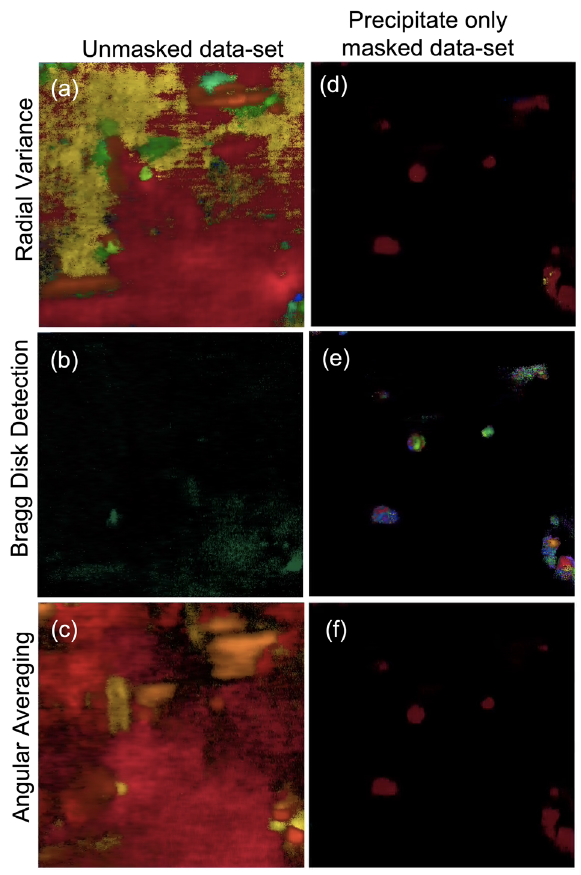
Fig. 13 Domain mapping using other techniques. The left column is the unmasked full thin foil Al alloy dataset clustered using a radial variance, b Bragg disk detection and c angular averaging. The right column is the precipitate-only masked thin foil Al alloy dataset clustered using d radial variance, e Bragg disk detection and f angular